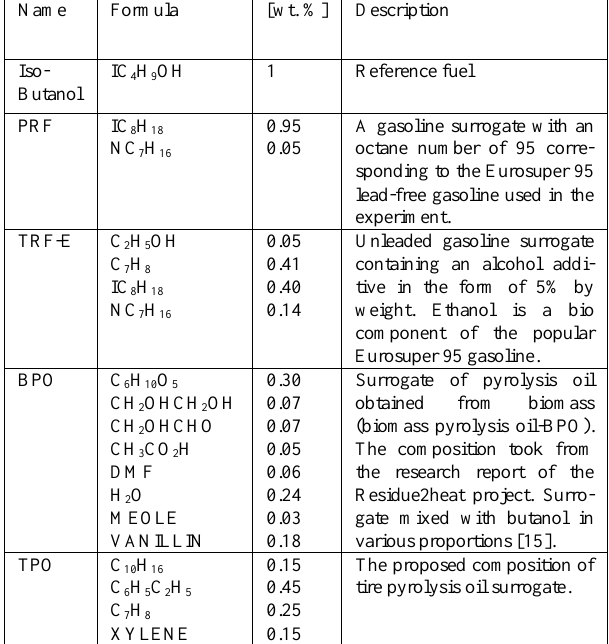
is presented in Table 4. Table 4. Composition of surrogate of fuel [12,